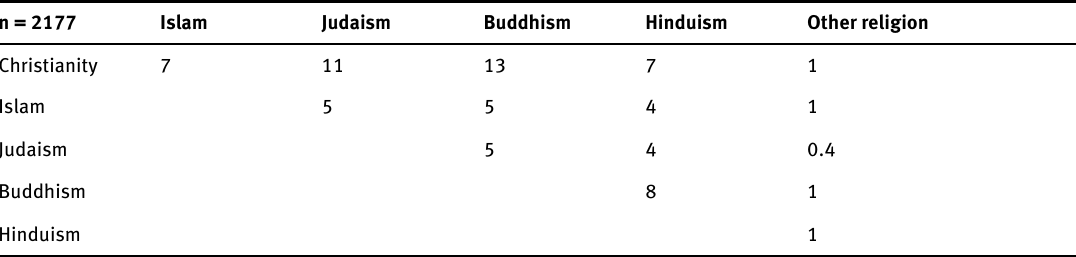
Figure 1. Cultural Christianity, ‘cultural multireligiosity’ and Multiple religious belonging. Going back to those MRBers, table 5 shows which combinations of religions are found. Table 5. Combinations of religious traditions (percentage of the total